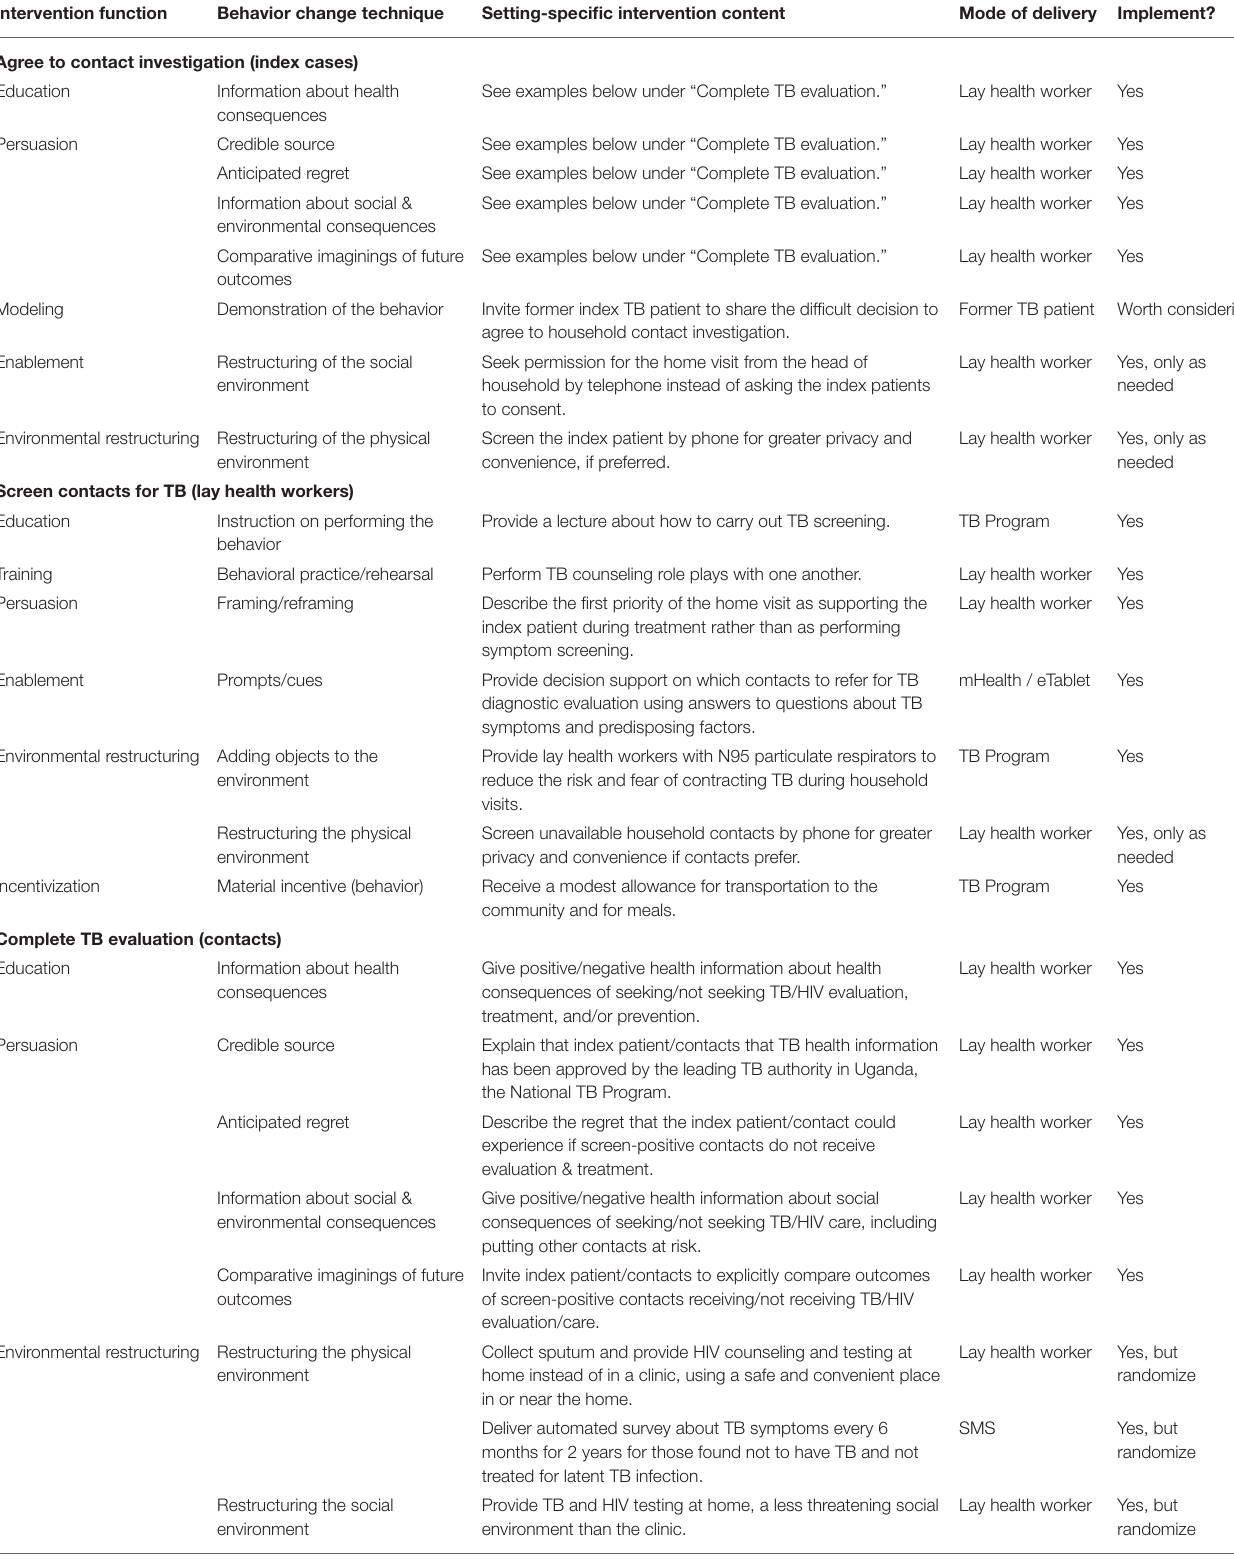
TABLE 3 | Selected behavior change techniques, setting-specific intervention content, and modes of delivery for each of the target behaviors. Intervention